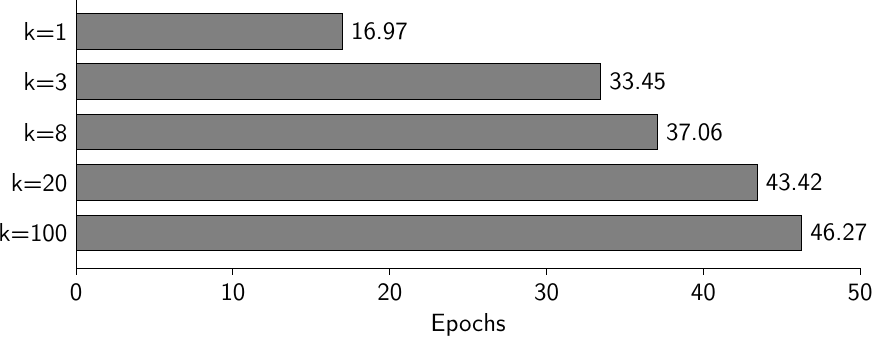
Figure 9. Number of epochs until the end of the learning process.